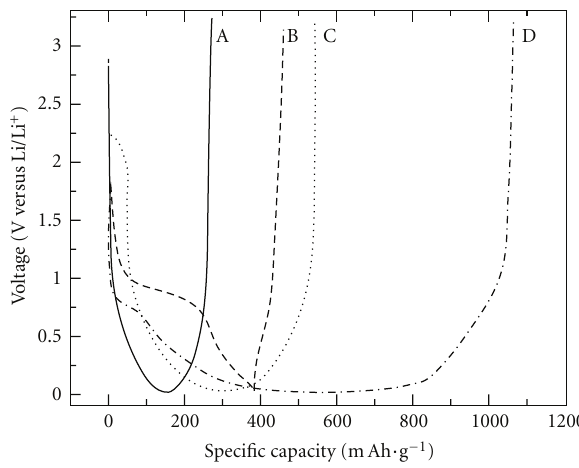
Figure 18: First charge/discharge for carbon felt (A) and BDD/CF electrodes doped from 10 18 up to 10 21 part cm − 3 (B, C, D) (reprinted with permission from